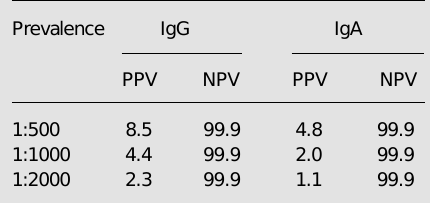
Table 3. Positive (PPV) and negative predictive values (NPV) reported as percent of antigliadin IgG and IgA antibodies based on hypothetical val- ues of prevalence.